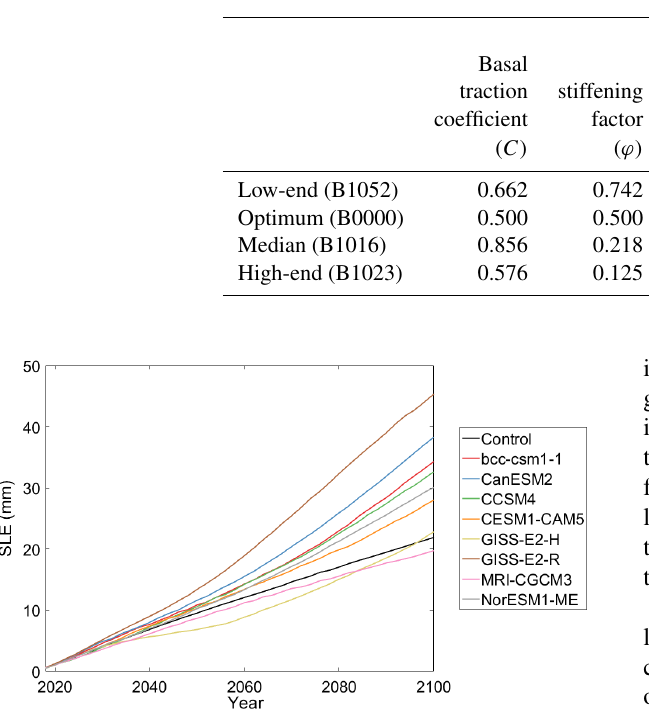
Figure 4. Projected 21st century SLE from the ASE in response to ocean temperature forcing projected by a subset of CMIP5 AOGCMS under the RCP8.5